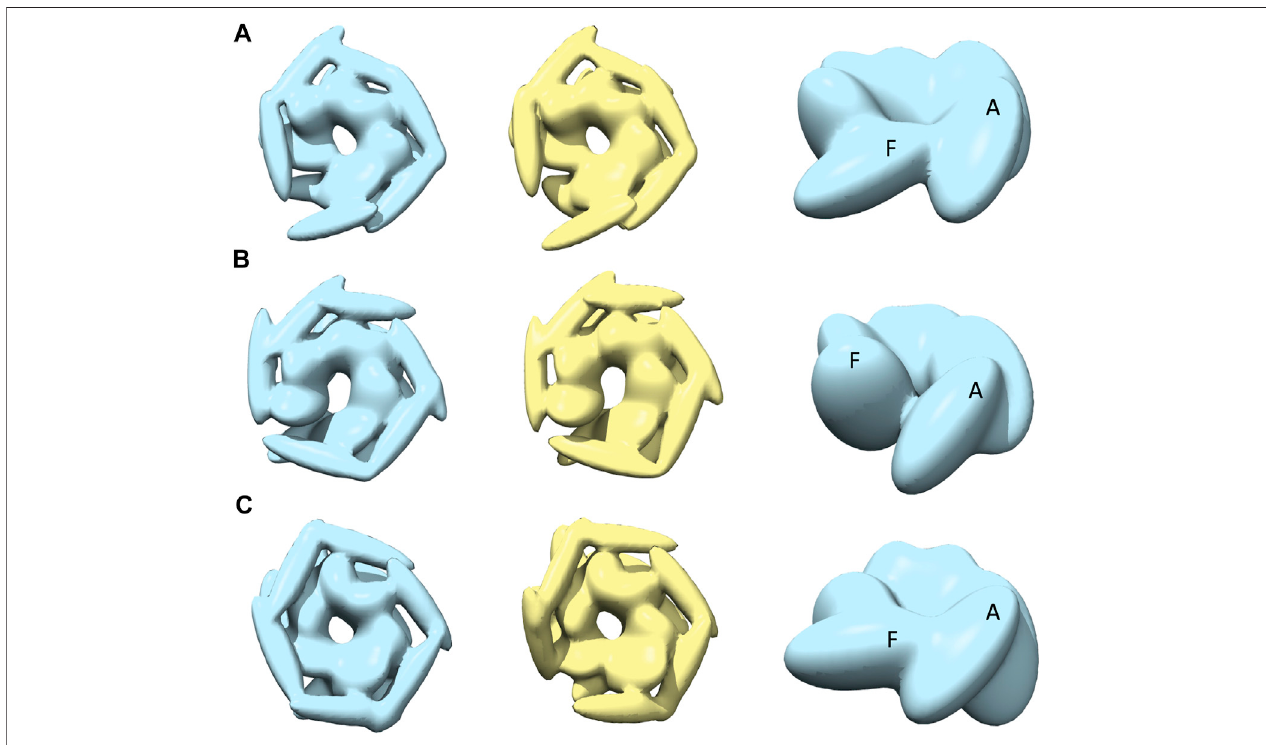
FIGURE 4 | The most converged model between structural modelling starting from R and S models for open class AFM images. The rows (A – C) are for AFM images 1, 2 and 3, respectively. The left column shows candidate solutions from R (light blue) and middle column shows candidate solutions from S (yellow). In the right column, only the body kernel is shown from R candidate solutions given in the left column. Chains A, F are indicated on top of the